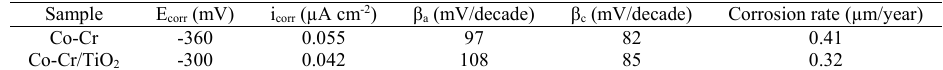
Table 3. Electrochemical parameters obtained from polarization curves